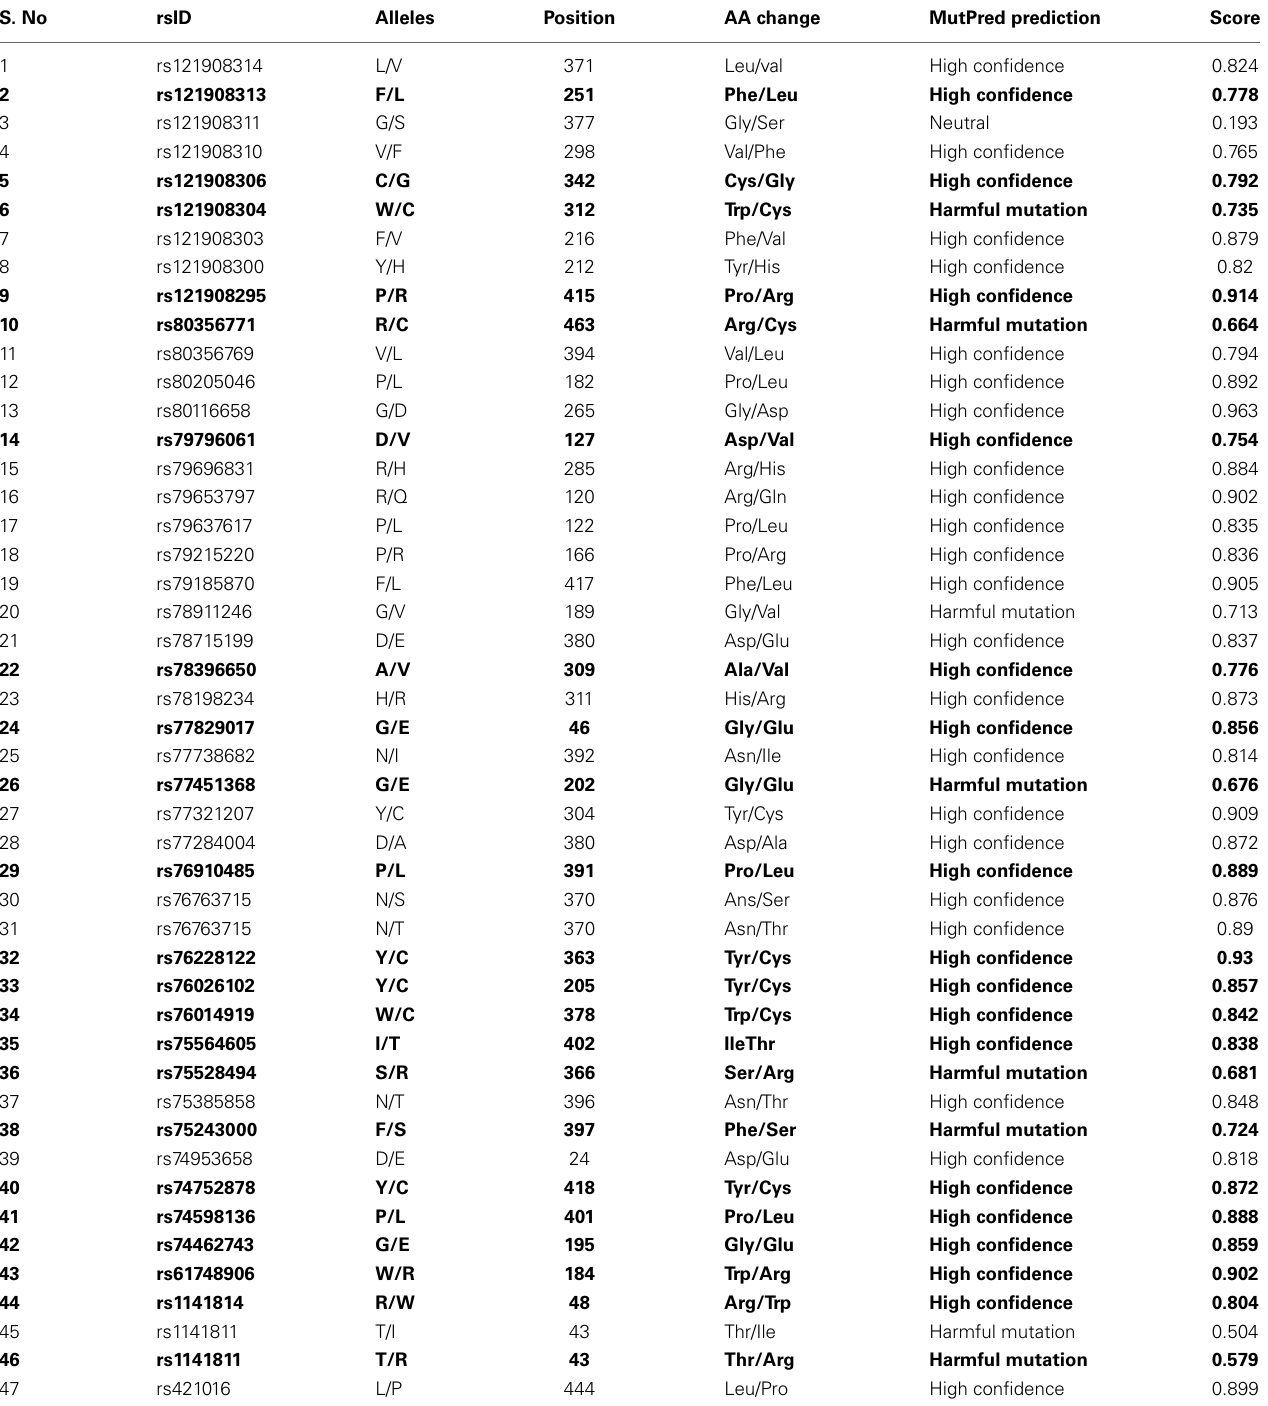
Table 2 | Prediction of functional effects of nsSNPs using